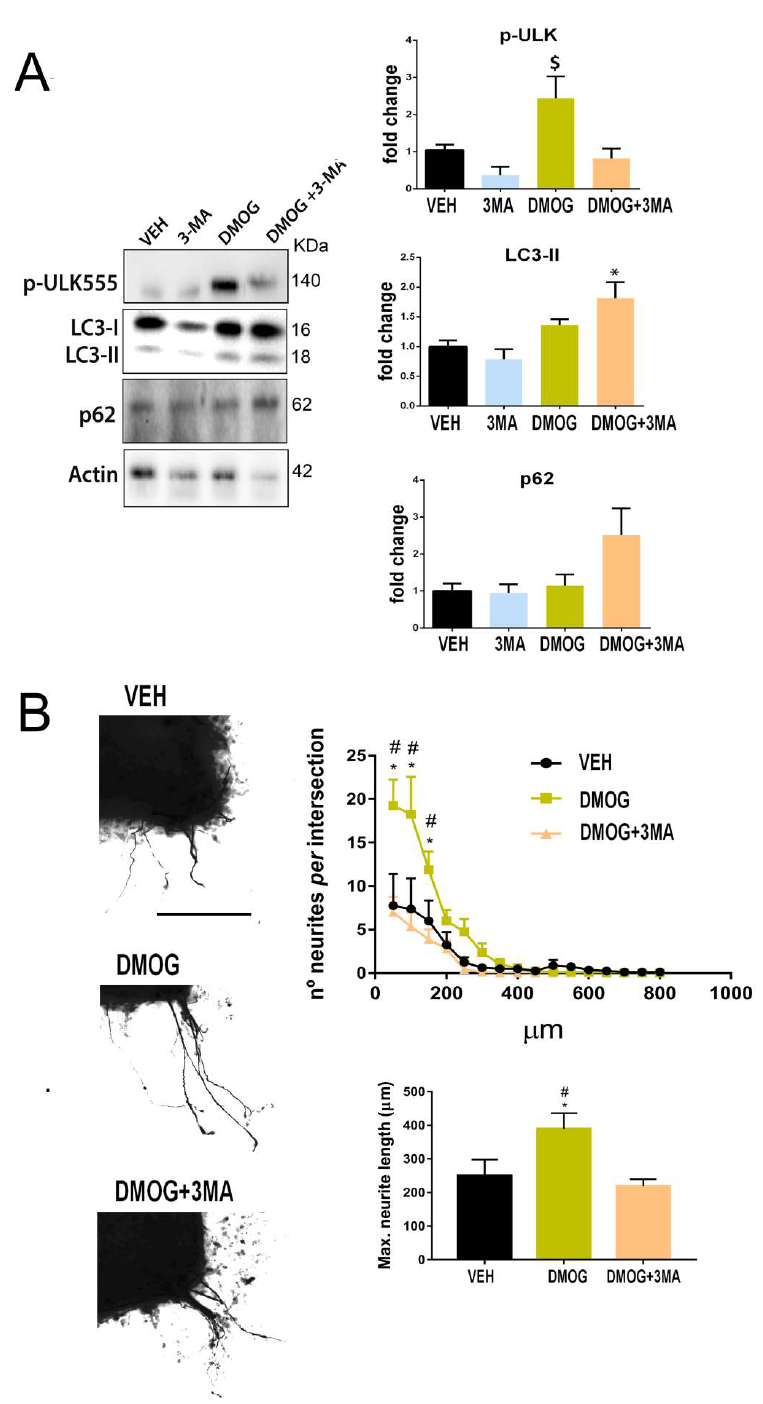
Figure 5. Hif-1α-dependent autophagy increases motor axon growth. ( A ) Western blots and histogram showing the analysis of pUlk1 (Ser555), ATG5-ATG12 LC3II, and p62 protein level from SOCs after 2 days of treatment with vehicle (Veh), DMOG, 3-MA, or DMOG+3-MA (n = 3–4, ANOVA, post hoc Bonferroni * p < 0.05 vs. DMOG, # p < 0.05 vs. Veh). ( B ) Representative microphotographs of Veh-, DMOG-, and DMOG+3MA-treated SOCs embedded in collagen. Graphs show the number of neurites per intersection and the maximum neurite length in the SOCs (n = 8–9, ANOVA, post hoc Bonferroni, * p < 0.05 vs. Veh, # p < 0.05 vs. DMOG+3MA). Scale bar = 250 μm.